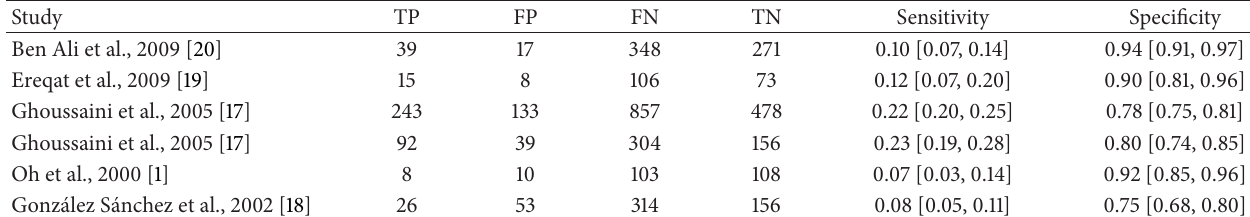
Table 3: Sensitivity and specificity for Pro 12 Ala polymorphism and